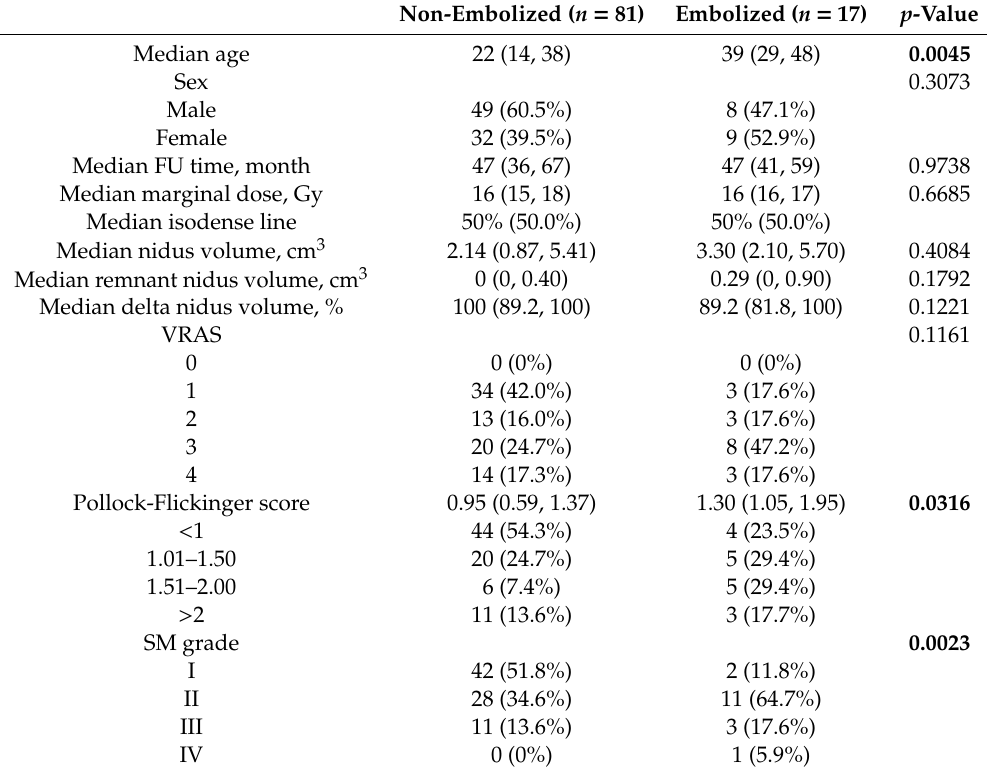
Table 1. Comparison of baseline demographic data, arteriovenous malformation (AVM) characteristics, and radiosurgical